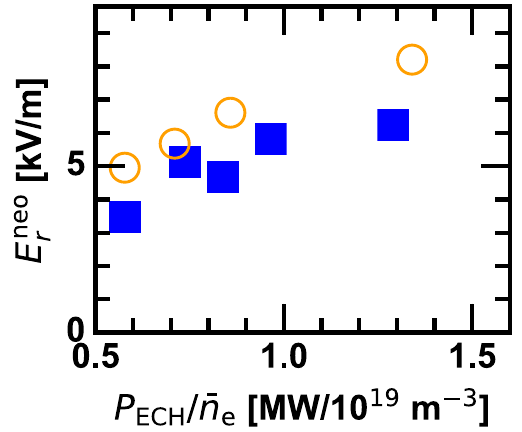
Figure 8. Numerically predicted neoclassical ambipolar radial electric field in the ECH applied